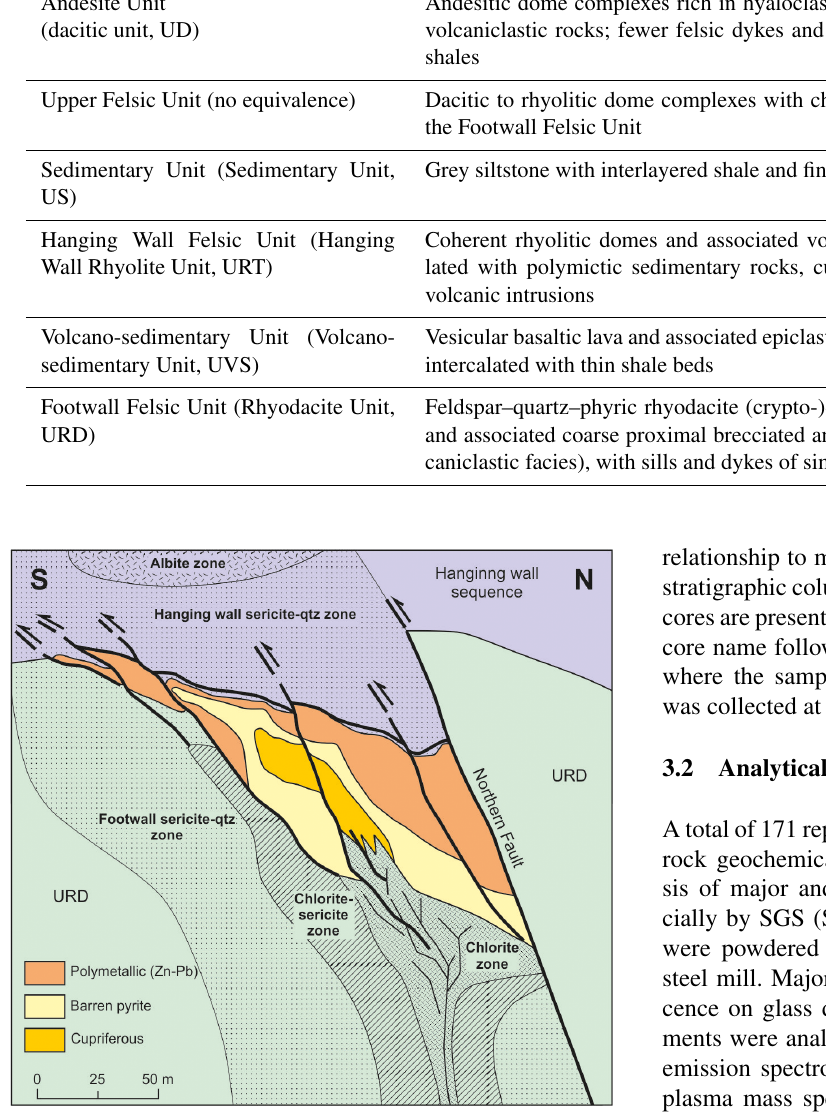
Figure 4. Schematic cross section of the Aguas Teñidas deposit based on Sánchez-España et al. (2003). It includes shear zones de- scribed by McKee (2003) at the top of the massive sulfides and ob- served in this study, as well as hanging wall alteration zones de- scribed in this